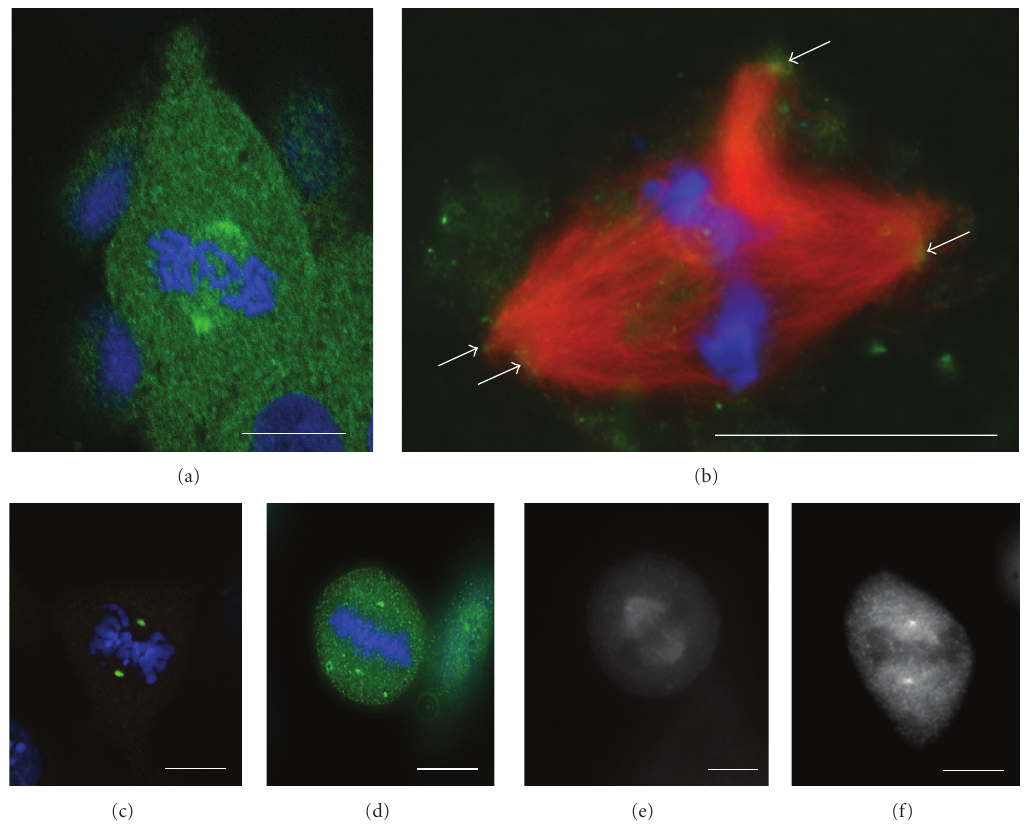
Figure 1: Immunofluorescence localization of TCTP in Xenopus laevis mitotic spindles using XlTCTP antibody. (a) Confocal section of an XL2 cell showing the presence of TCTP in the spindle with higher density at the spindle poles. (b) Isolated spindle formed by sperm-head addition to the CSF extract. Red MTs stained with rhodamine- β -tubulin added to the extract, green TCTP detected by immunofluorescence with XlTCTP antibody. White arrows point to spindle poles with TCTP staining. Blue DNA stained with DAPI. Note the presence of yellow staining of TCTP at the spindle poles and the absence of TCTP in the remaining parts of the spindle. (c) Confocal section of murine metaphase NIH3T3 cell stained with XlTCTP antibody (green) and with DAPI for DNA. Note that XlTCTP stains exclusively two distinct spots corresponding to the centrosomes, at the spindle poles corresponding. (d) Confocal section of human HeLa metaphase cell. Green TCTP detected with XlTCTP antibody, blue DNA. XlTCTP stains two spindle poles; the granular background staining is also visible in the cytoplasm. (e) Human HeLa metaphase cell. Green TCTP detected with homologous HsTCTP antibody, blue DNA. HsTCTP stains the whole spindle. (f) Monkey Cos7 metaphase cell incubated with anti-rat TCTP antibody showing a very distinct staining of spindle poles. Bar is equal to 20 μ